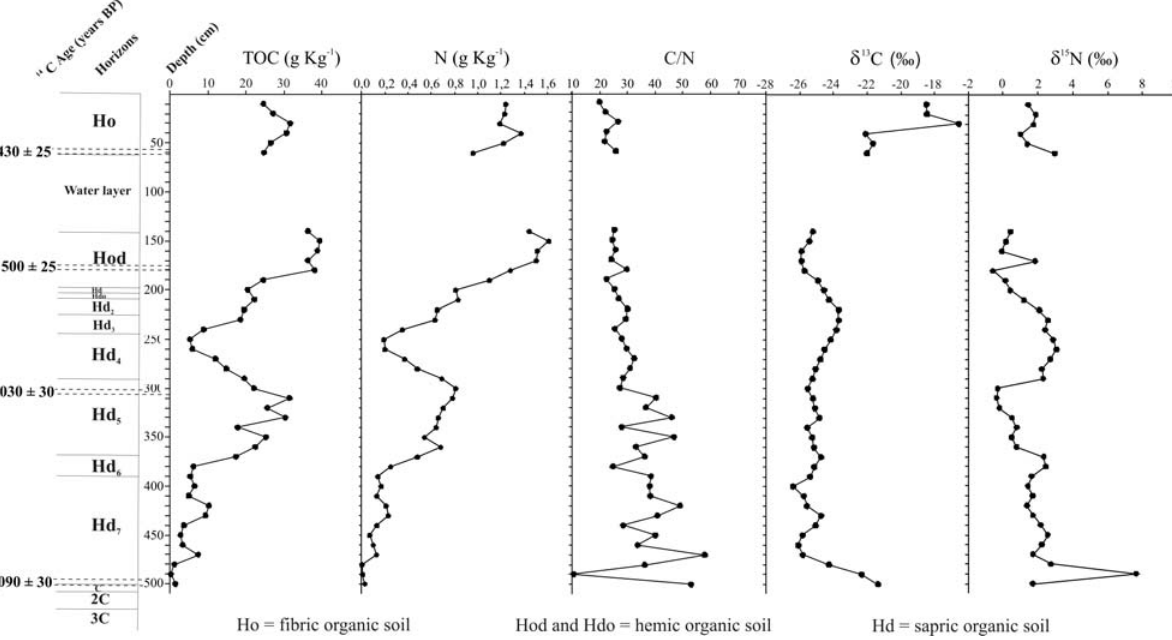
Figure 7. Distribution of TOC, N, C/N, δδδδδ 13 C and δδδδδ 15 N contents in depth in the profile of the peatland from Pau- de-Fruta